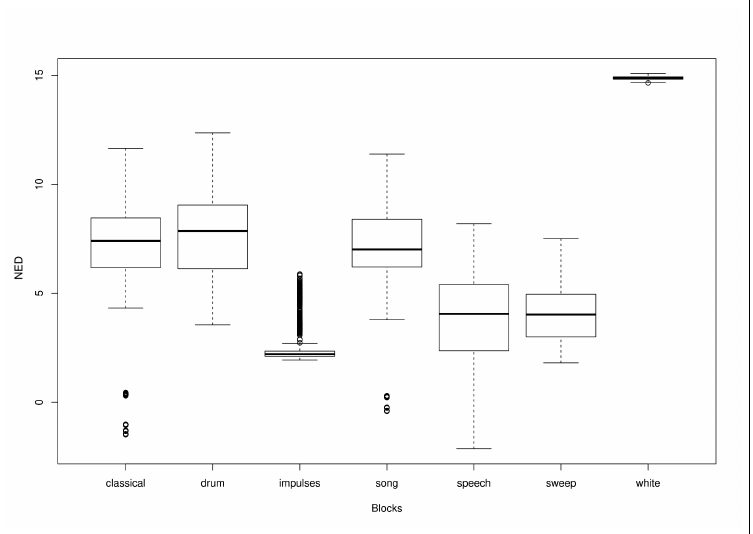
Figure 8. Boxplot of NED for non-congruent